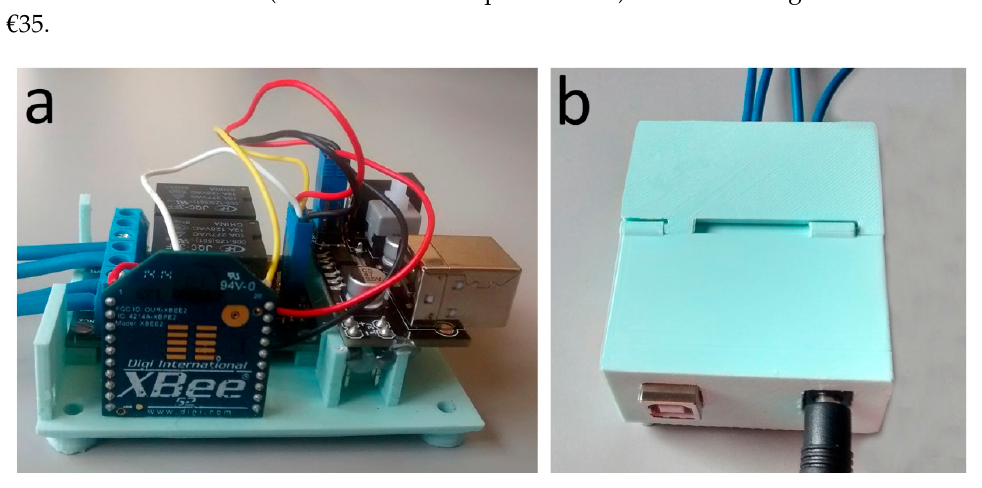
Figure 4. Receiving actuation station: ( a ) internal connection; ( b ) external case.